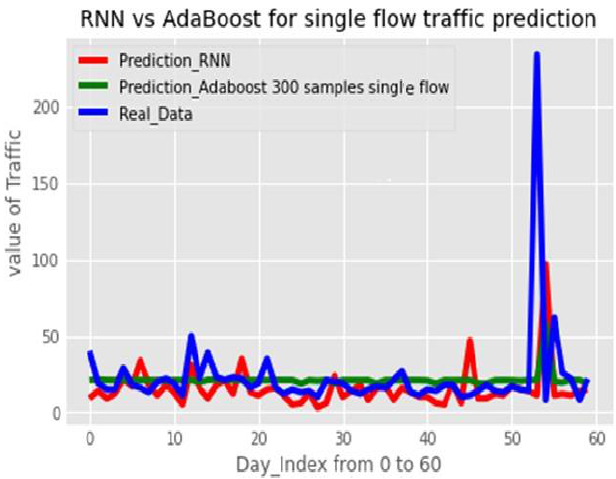
Figure 13. RNN predictor and AdaBoost predictor for 300 training samples single flow.